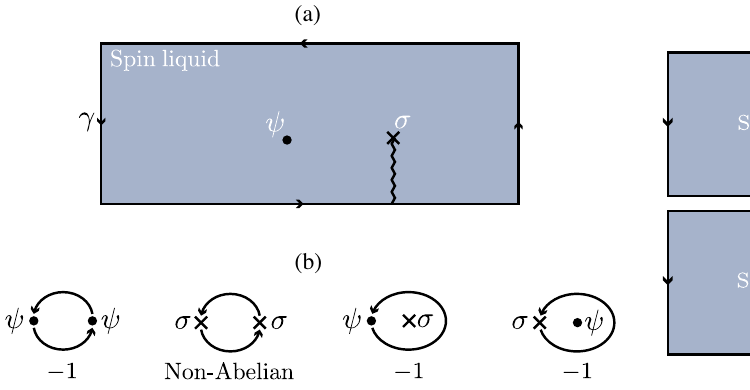
FIG. 2. Non-Abelian spin-liquid synopsis. (a) The boundary hosts a gapless chiral Majorana mode, while the bulk supports two nontrivial gapped quasiparticle types: emergent neutral fermions ψ and Ising non-Abelian anyons σ . Fermions acquire a minus sign on crossing the wavy line (which represents a branch cut) emanating from σ . (b) Summary of quasiparticle braiding statistics.